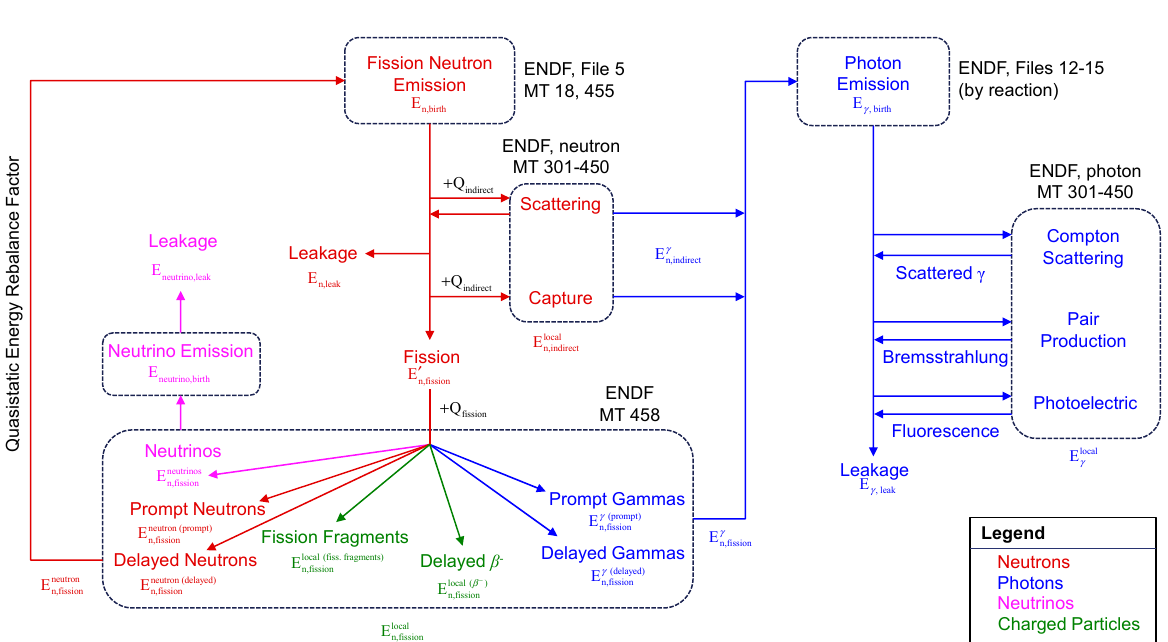
Figure 1. Illustration of energy release, deposition, and conversion mechanisms for neutrons, photons, charged particles, and neutrinos in a nuclear reactor. Evaluated Nuclear Data File (ENDF) reaction numbers (i.e., MT numbers) associated with energy release/deposition are listed for each reaction category.